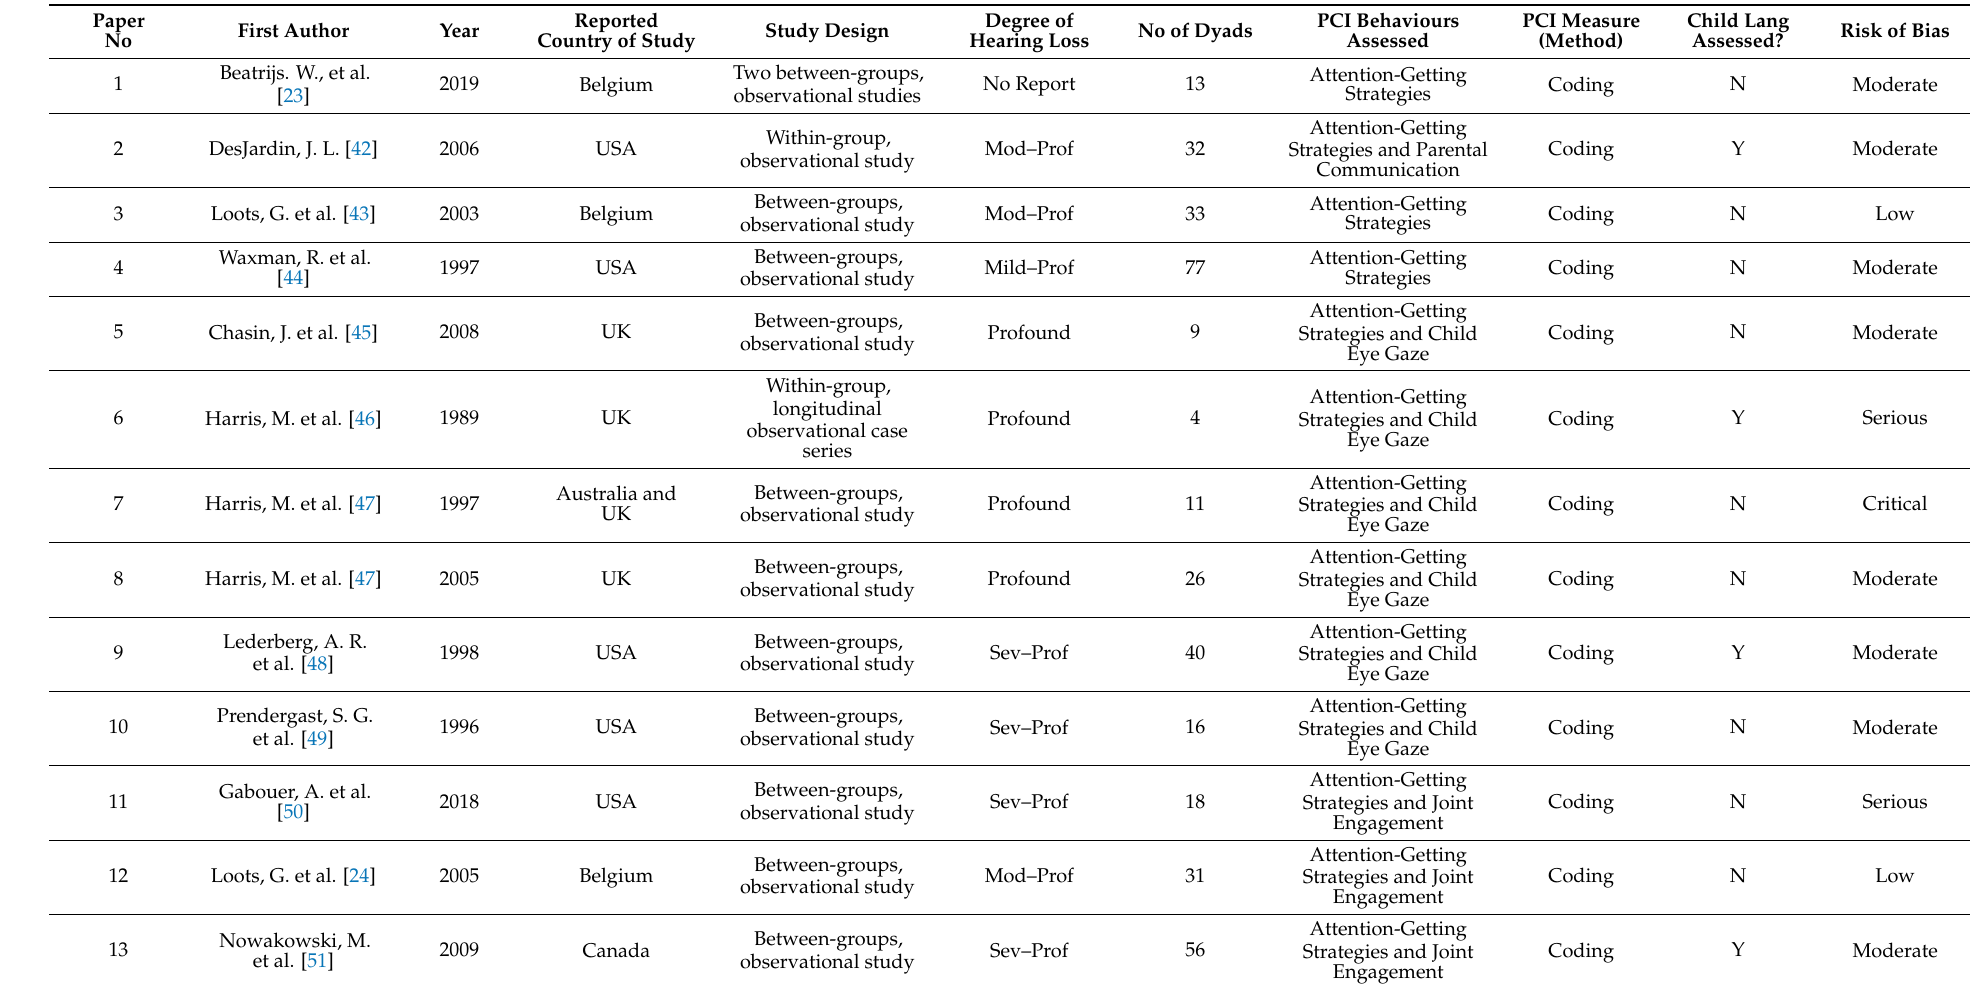
Table 1. Papers included in the review ( n = 61) and the associated research